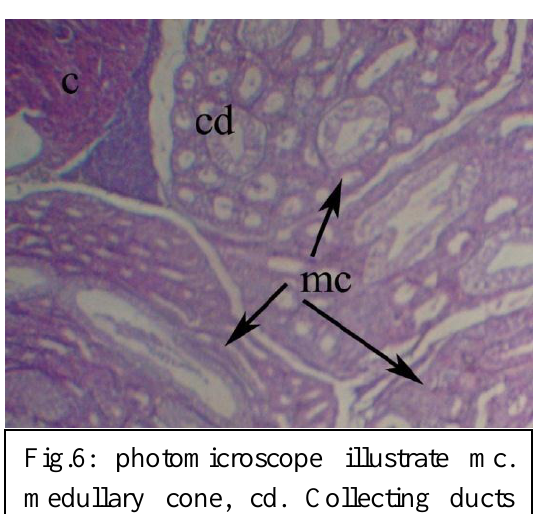
Fig.6: photomicroscope illustrate mc. medullary cone, cd. Collecting ducts and c. cortex. (HandE,